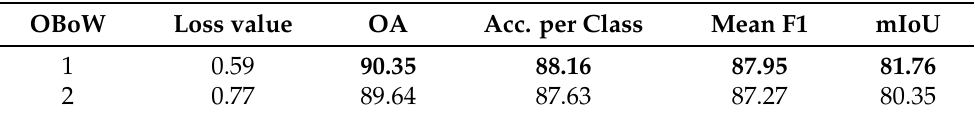
Table 8. Ablation study about OBoW configuration: lower losses in the OBoW training process of the ResNet-18 feature extractor correspond to lower performances in the downstream